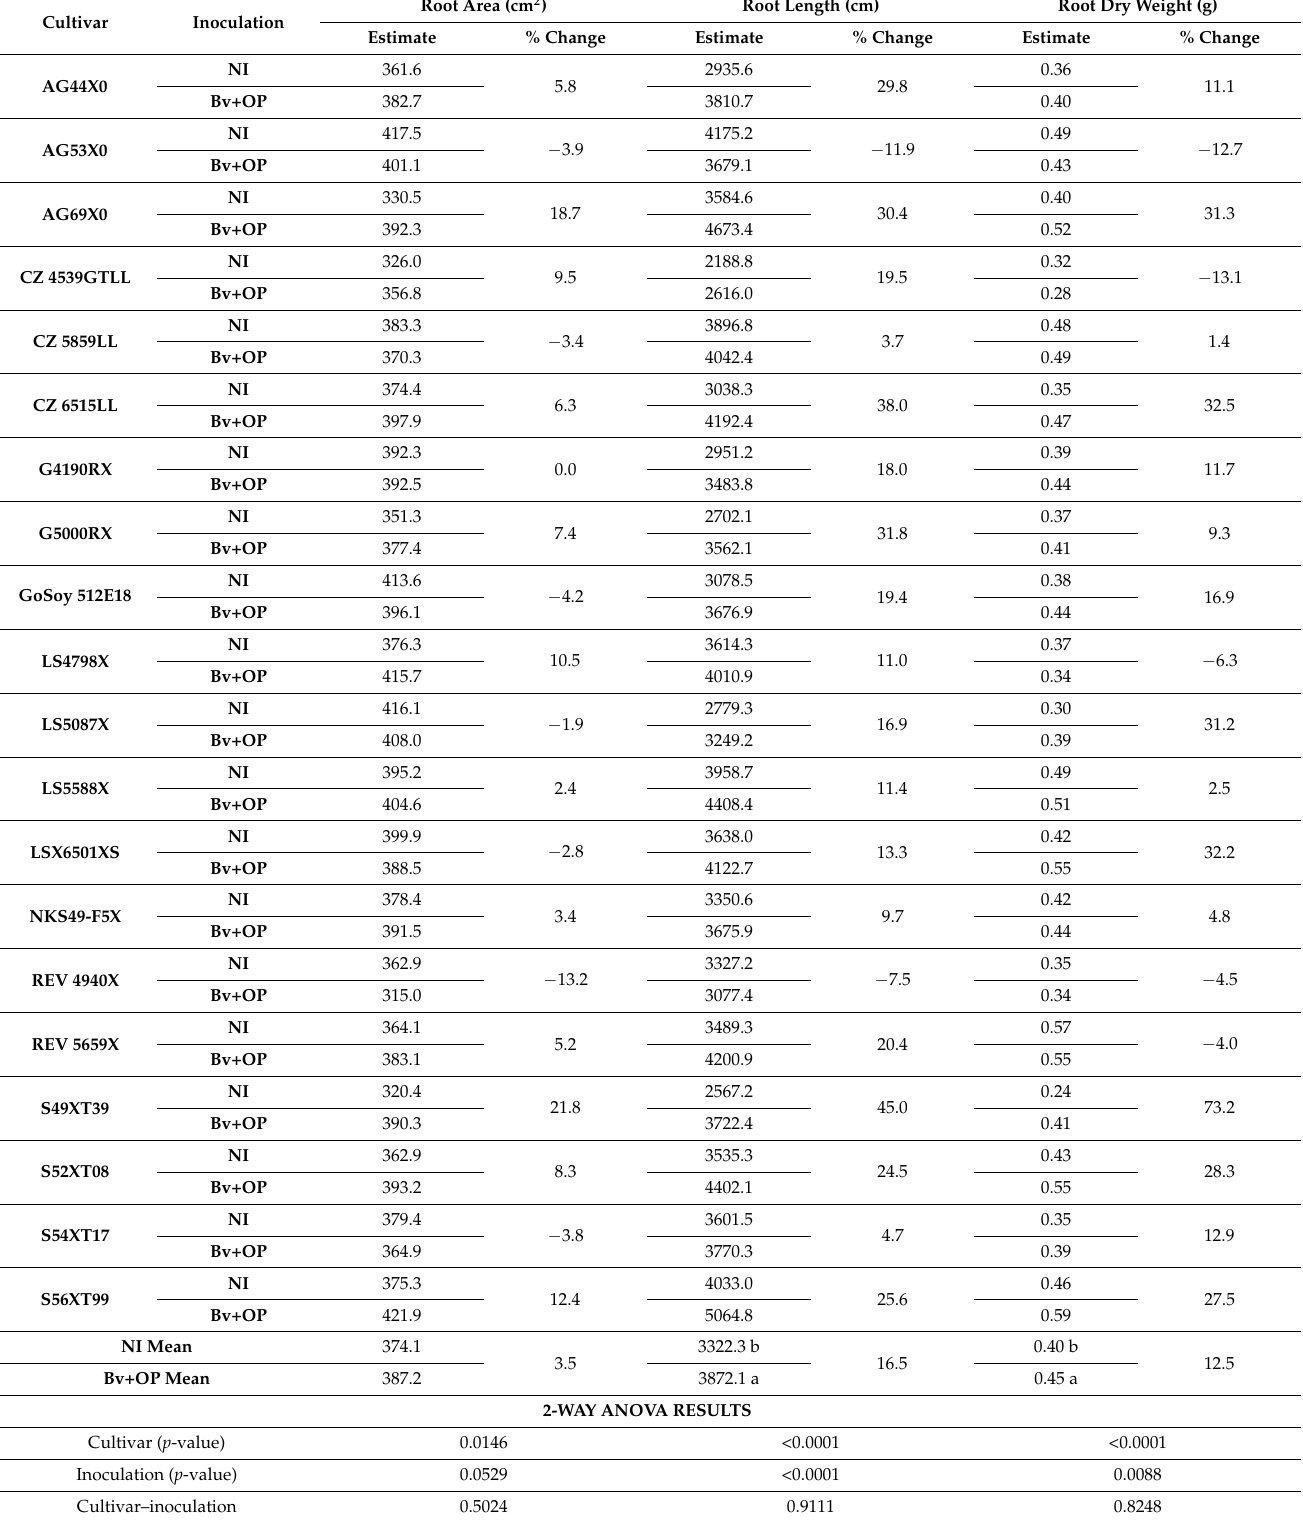
Table 3. Response of inoculation with Bv AP193 plus OP on root area, root length and root dry weight in a preliminary greenhouse experiment with 20 soybean cultivars. The bottom section of the table shows the ANOVA results ( p -value) for the effect of cultivar, inoculation and the interaction cultivar–inoculation. Different letters indicate significant differences within the treatment